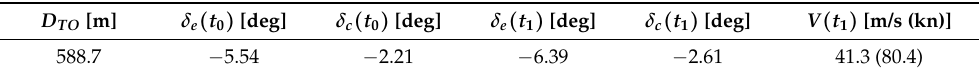
Table 6. Parameters for optimal take-off, for a three-surface aircraft with control linkage tuned for optimal